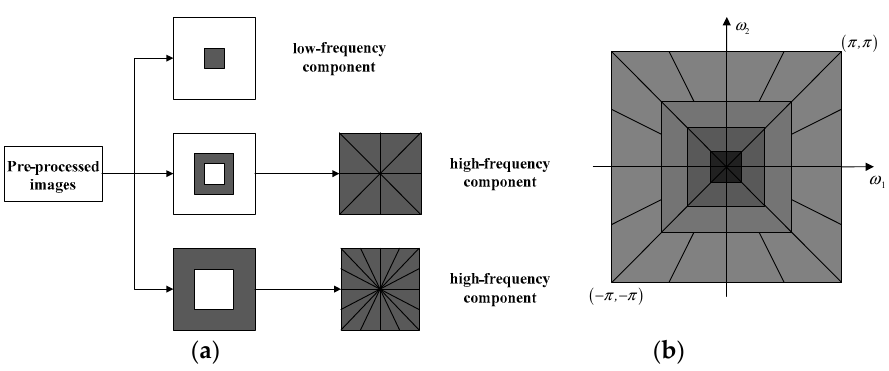
Figure 4. The structure of NSCT: ( a ) NSP filter; ( b ) NSDFB frequency decomposition.